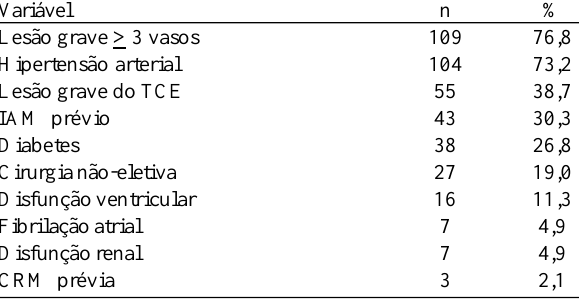
Tabela 1. Descrição pré-operatória da amostra estudada.